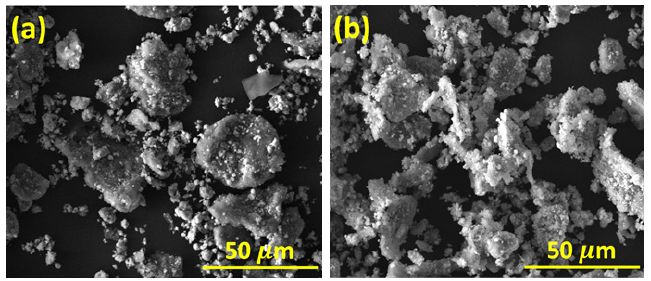
Figure 3. SEM micrograph of Al-CuO powders after ( a ) 30 and ( b ) 90 min of ball milling.